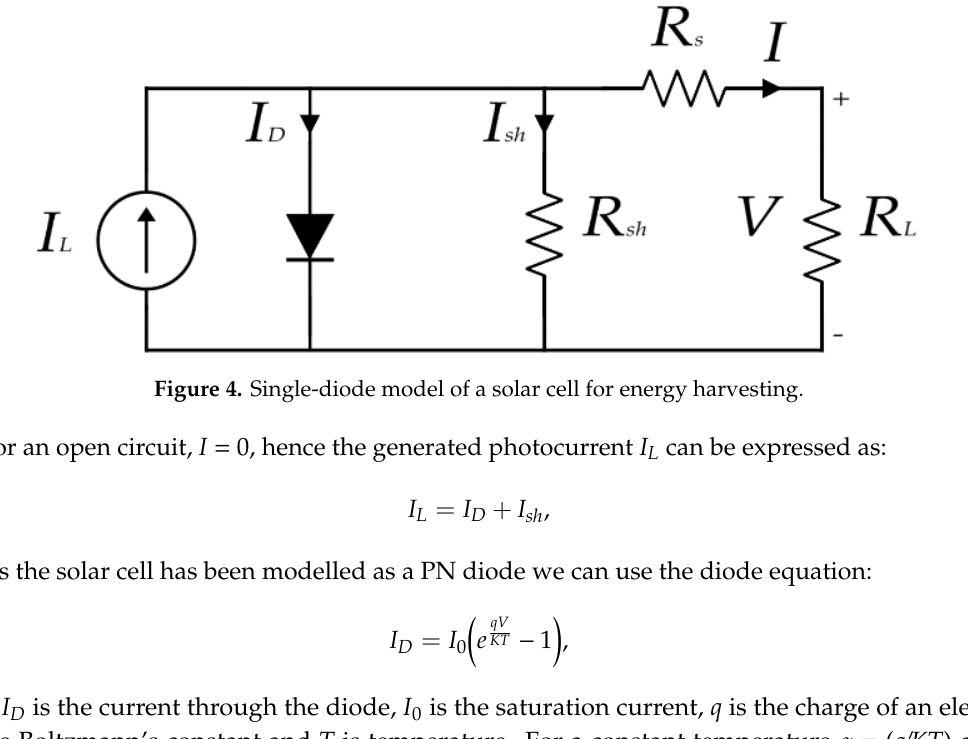
Figure 4. Single-diode model of a solar cell for energy harvesting.